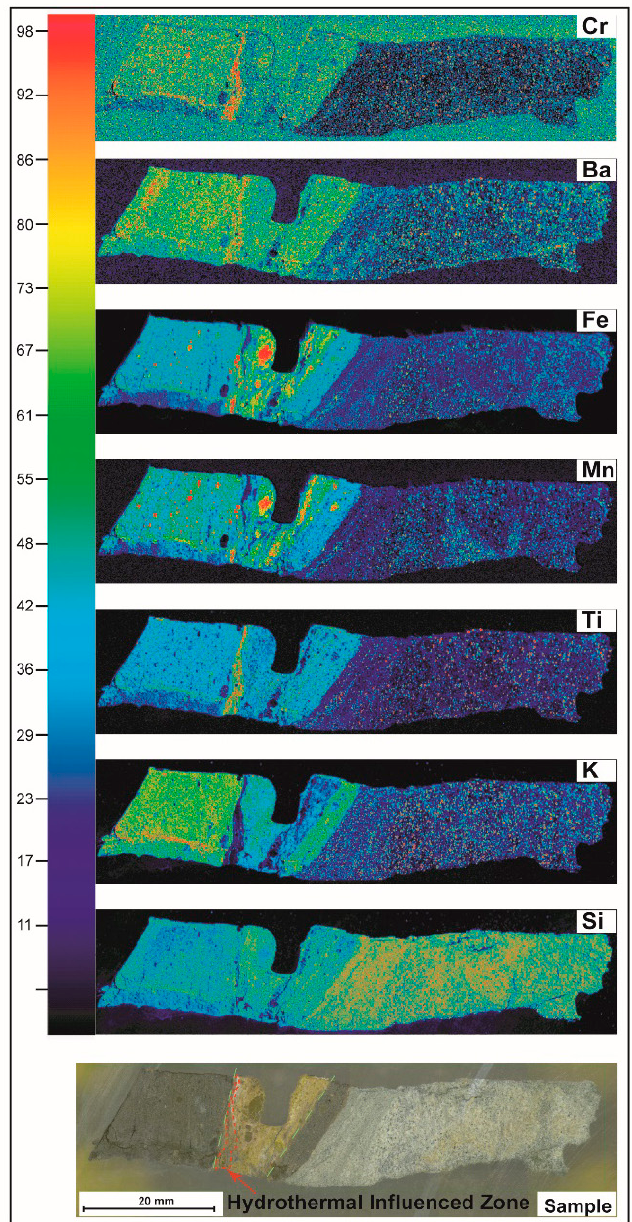
Figure 2. X-ray fluorescence (XRF) map of the Jiulong trench samples. The 2008 slip zone lies at the top of the middle yellowish gouge layer. The chromatographic column numbers indicate the element abundances. The red lines show the location of the hydrothermal influenced zone (HIZ).